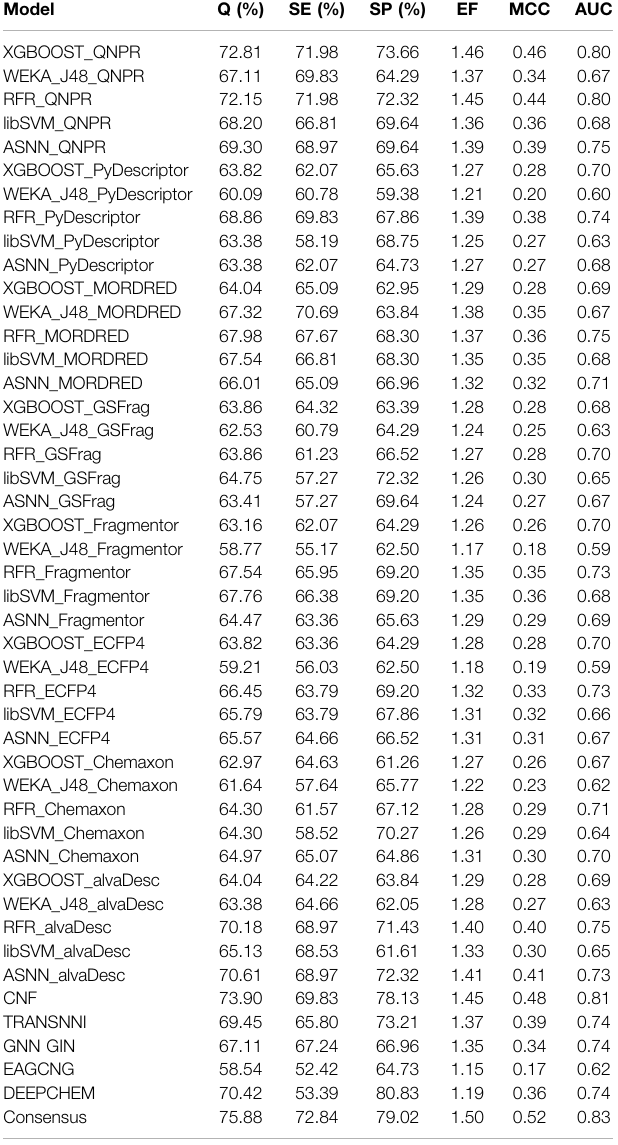
TABLE 2 | Performances of models on 5-fold